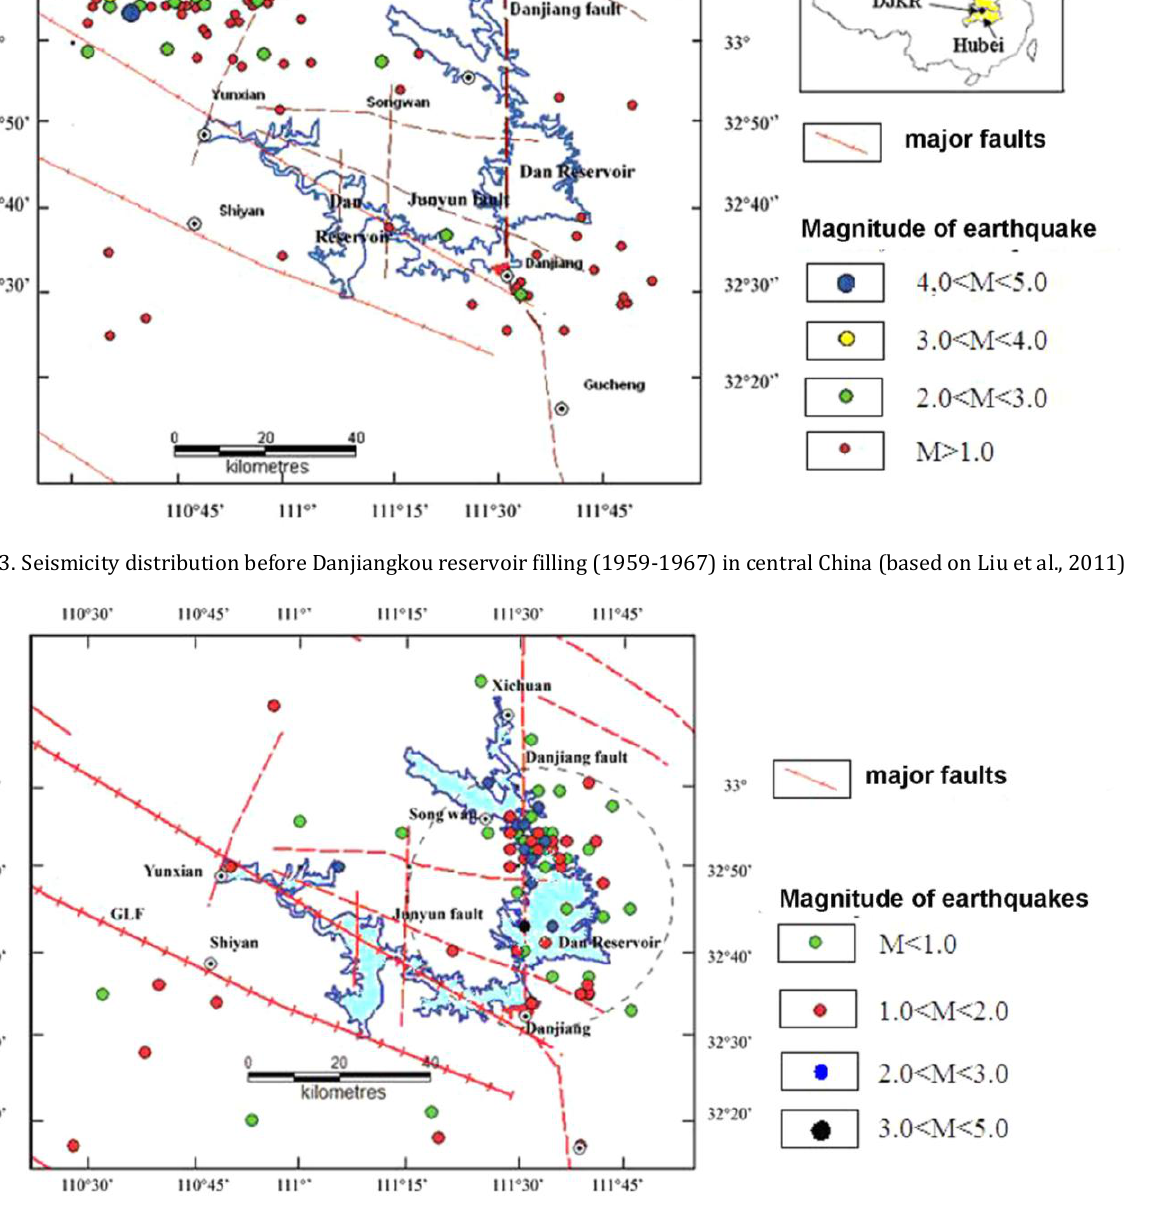
Fig. 4. Seismicity distribution after Danjiangkou reservoir filling (from 1967 to 1987). Dashed circle shows the area of intense seismic activity (based on Liu et al.,